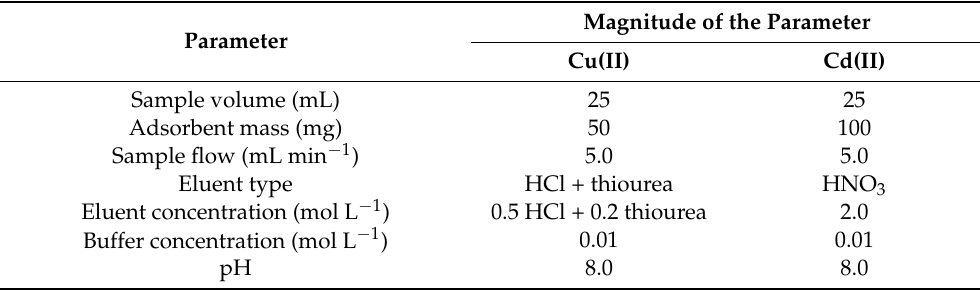
Table 6. Optimized conditions for the preconcentration of Cu(II) and Cd(II) using Si-Pu in